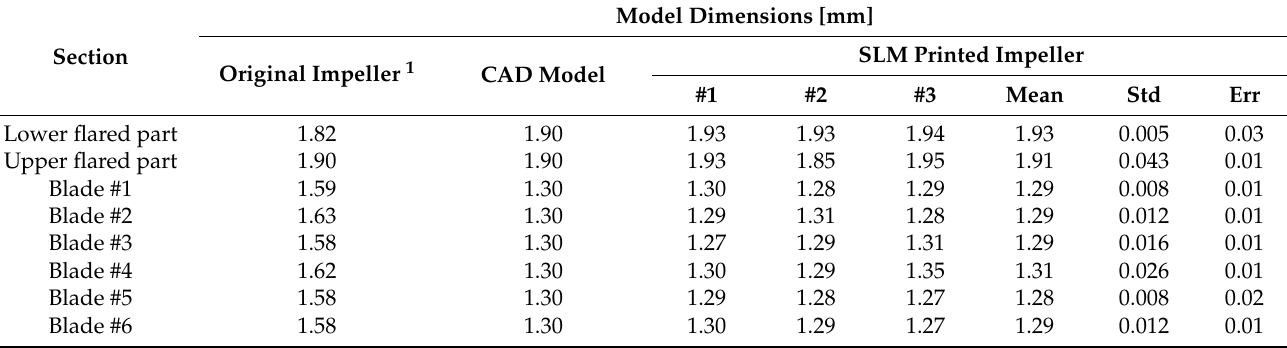
Table 8. Geometrical accuracy evaluation of the sections’ thickness of the 3D printed impeller through the measurement on three random points (indicated as #1, #2, and #3 for sake of simpleness). All the values are expressed in mm. “Std” stands for standard deviation; “Err” is the absolute error defined as the difference between the measured (average) and the estimated (from CAD model) values of the various thicknesses.